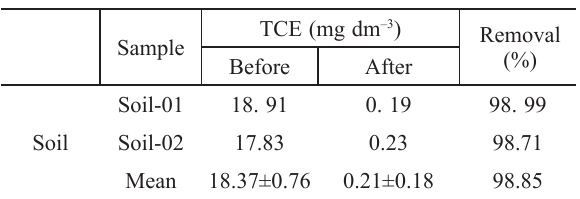
Table 7 – Concentration and standard deviation of TCE in soil samples before and after a fixed-bed column